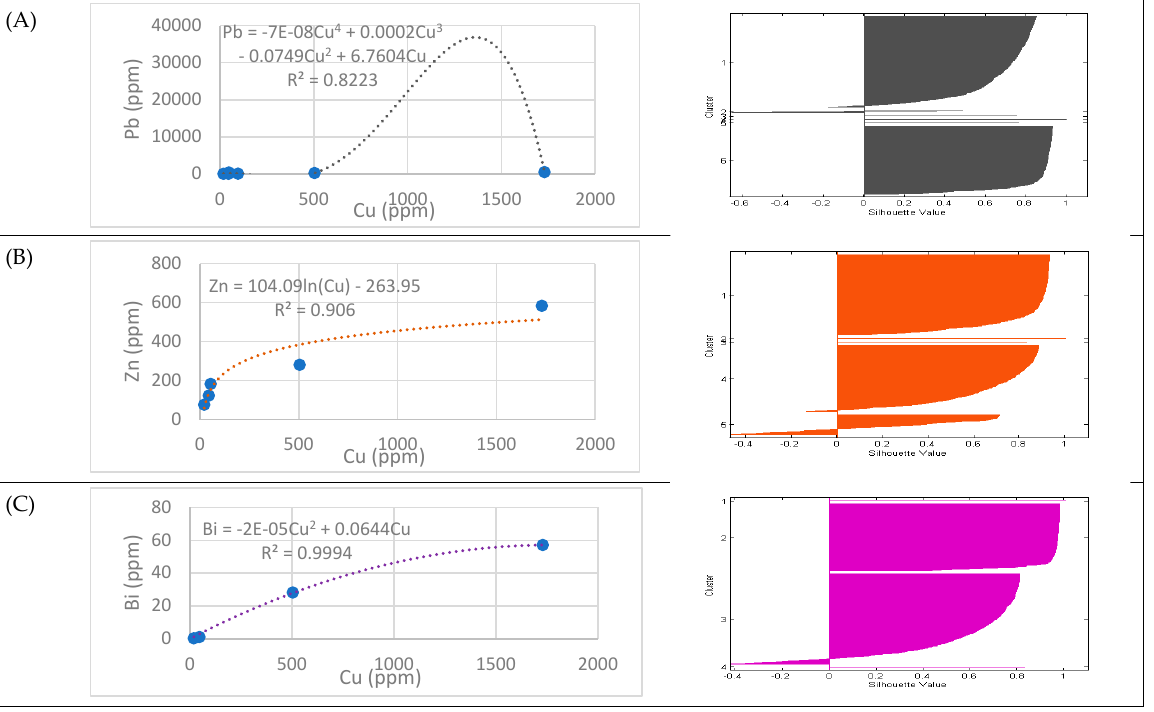
Figure 12. The profile of the clusters and the behavior of Cu and Pb, Zn and Bi concentrations in the centers of clusters. ( A ) Pb-Cu, ( B ) Zn-Cu, ( C ) Bi-Cu.